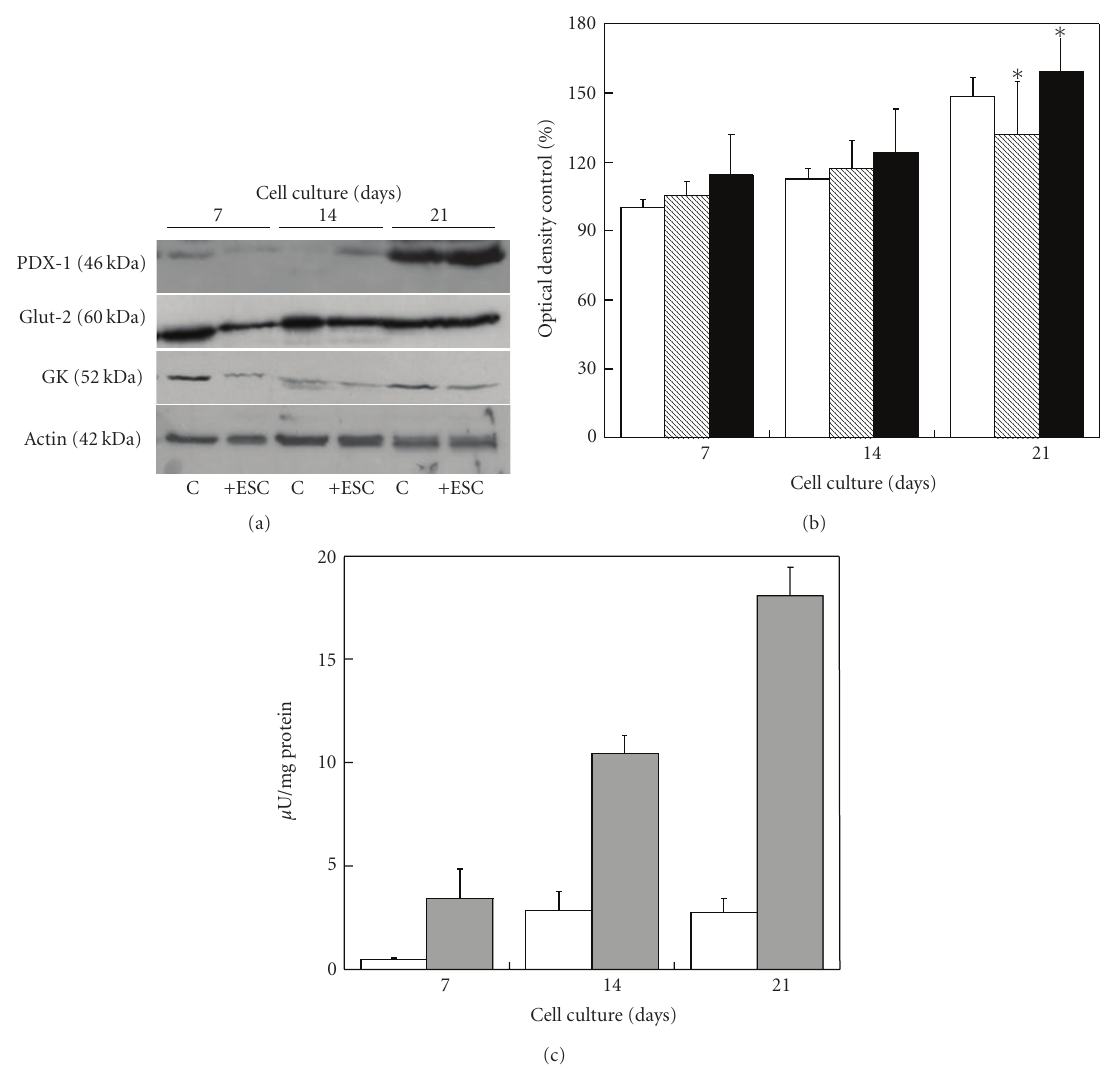
Figure 8: (a) Western blot analysis of the indicated proteins from control NPI cell monolayers (C) or NPI cell monolayers cocultured with ESC (+ESC) for the indicated time periods. (b) The relative intensities of PDX-1 (open bars), Glut-2 (hatched bars), and GK (filled bars) levels, as determined by band densitometric analysis. The ratio of the band intensities was expressed as a percentage with respect to untreated control NPI cell monolayers. Data are shown as means ± SD from 3 samples. ∗ Significant di ff erence between two groups at each time point ( P < . 05). (c) Ratio insulin content/mg total protein of control NPI cell monolayers alone (open bars), or NPI cell monolayers, cocultivated with microencapsulated SC (gray bars), for 7, 14, and 21 days of culture. Data are shown as means ± SD from 3